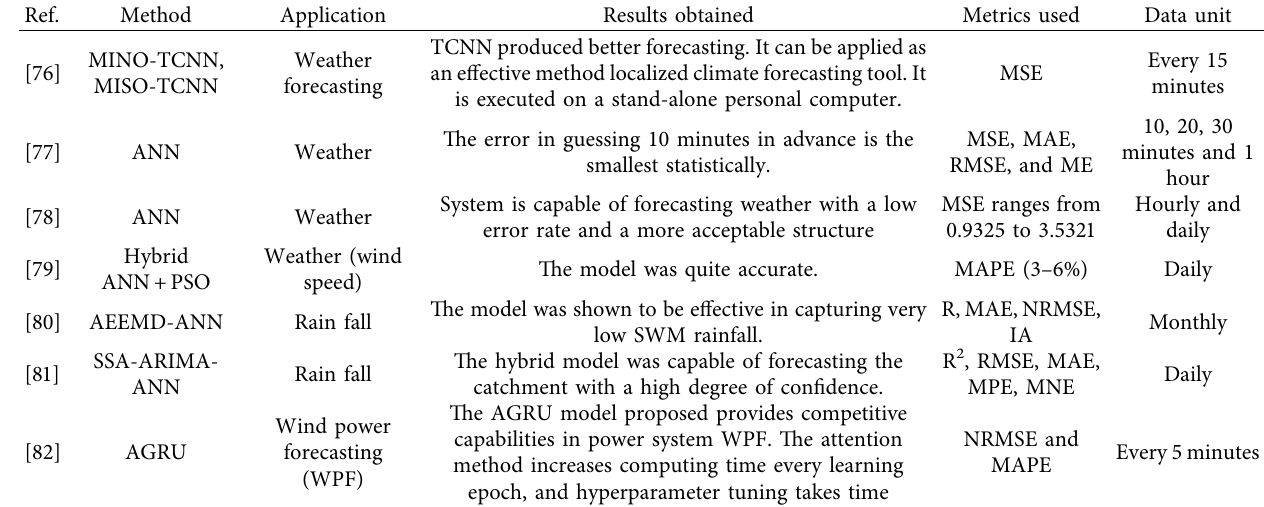
Table 5: A summary of published articles that used deep sequential models in weather predictions.